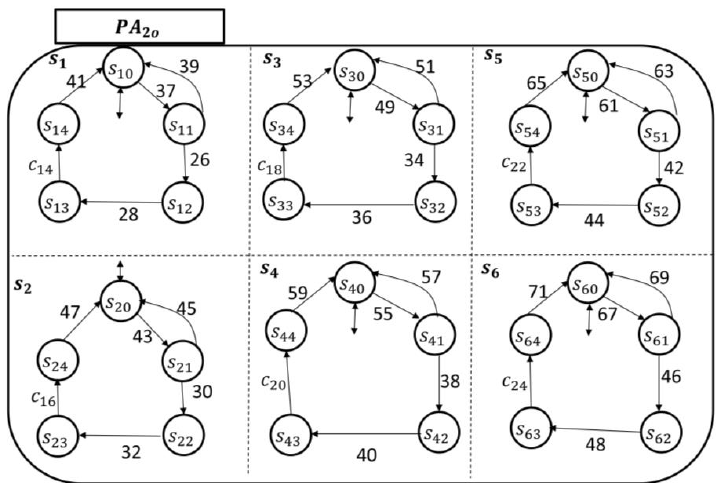
Figure 13. Patient automaton 𝑷𝑨 𝟏𝒐 transitional model.